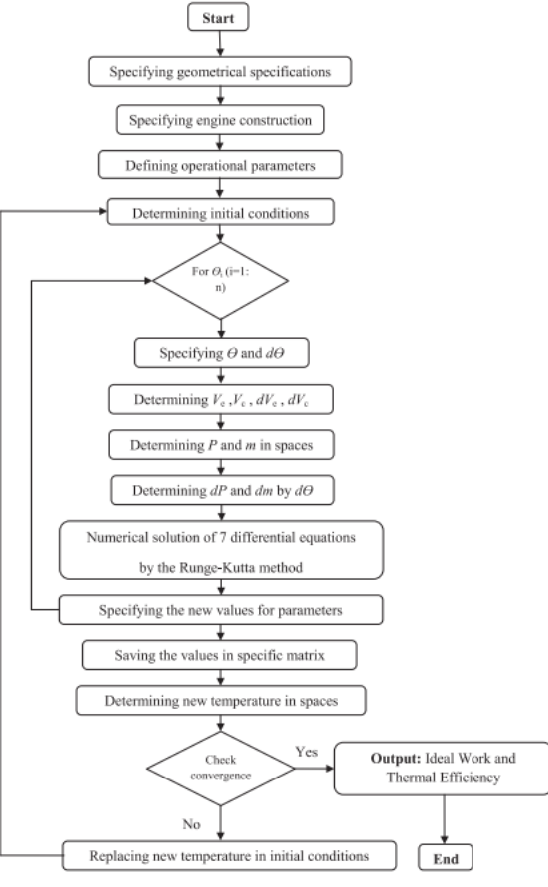
Fig. 13. Flow chart of the algorithm of ideal adiabatic model